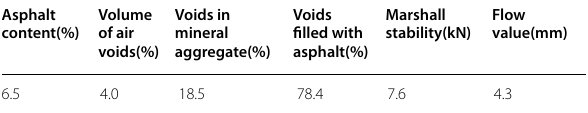
Table 3 The properties of the SMA-13 mixture Asphalt Volume content(%) of air